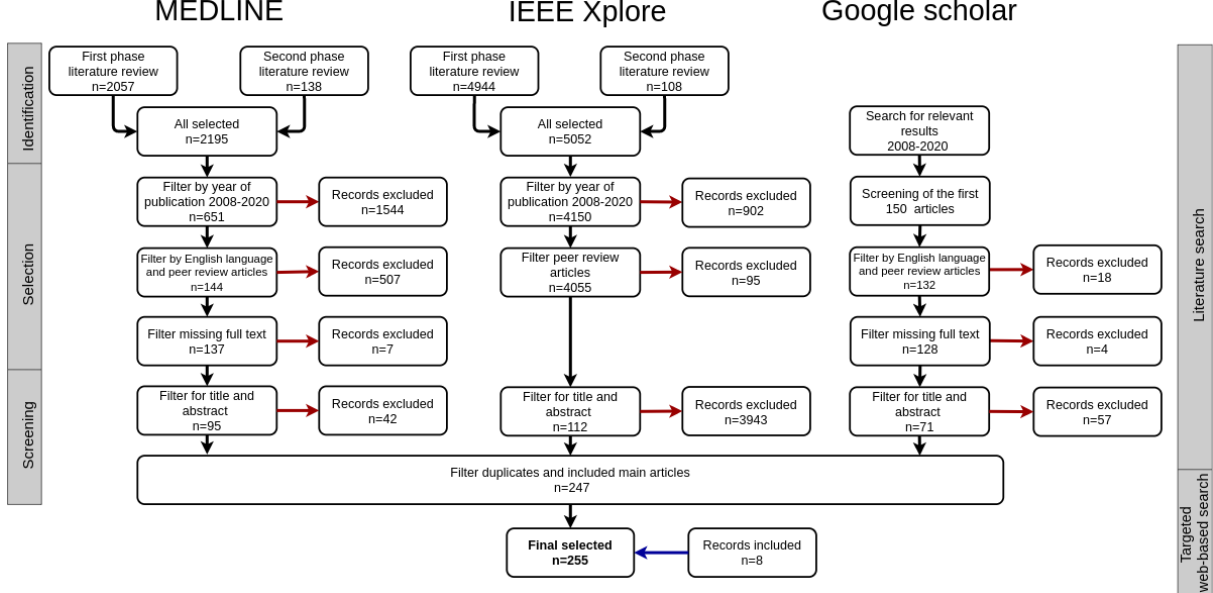
Figure 1. Article selection process. The diagram shows the number of articles at each stage of selection for each of the 3 databases: MEDLINE (Medical Literature Analysis and Retrieval System Online), IEEE Xplore (Institute of Electrical and Electronics Engineers Xplore), and Google